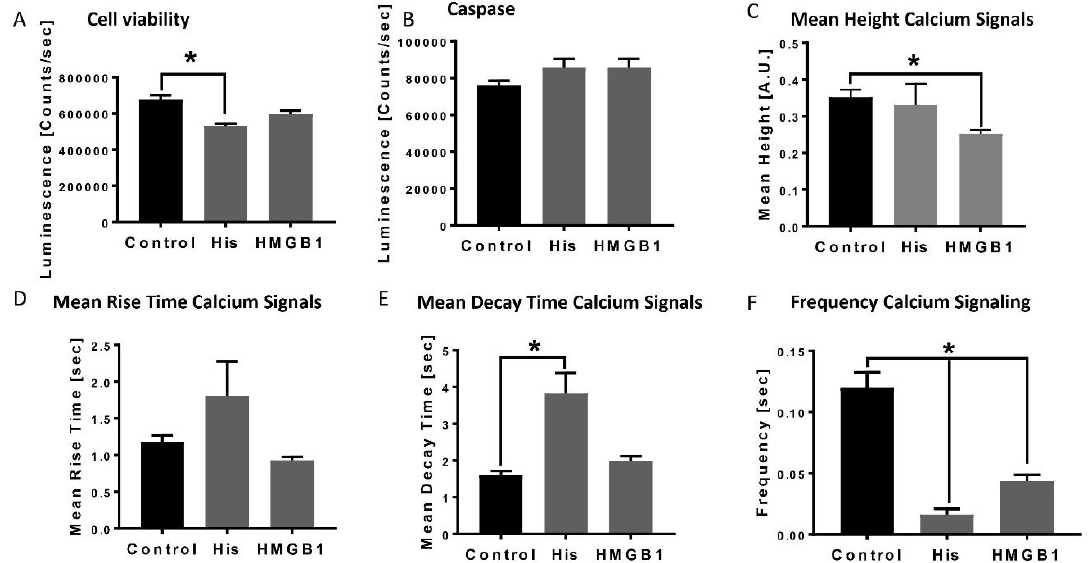
Figure 1. Decrease in cardiomyocytes viability, apoptosis and alterations of calcium handling in the presence of HMGB-1 and histones: Cell viability of human cardiomyocytes (Luminescence in counts/sec) in the presence of 20 µg/mL histones (His) and 100 ng/mL HMGB-1 (37 °C, 6 h) compared to the control (PBS) ( A ). Caspase-3/7 activity (counts/sec) in human CMs in the presence of histones and HMGB-1 ( B ). Mean Height calcium signals (A.U) in the presence of histones and HMGB-1 compared to the control ( C ). Mean rise time (sec) ( D ) and mean decay time (sec) ( E ) of calcium peaks of human CMs in the presence of histones and HMGB-1. Frequency of calcium signals (sec) in human cardiomyocytes treated 20 µg/mL histones and 100 ng/mL HMGB-1 ( F ). Results are presented as mean ± SEM, for all experiments n = 6. Indicated results were significant * p < 0.05.